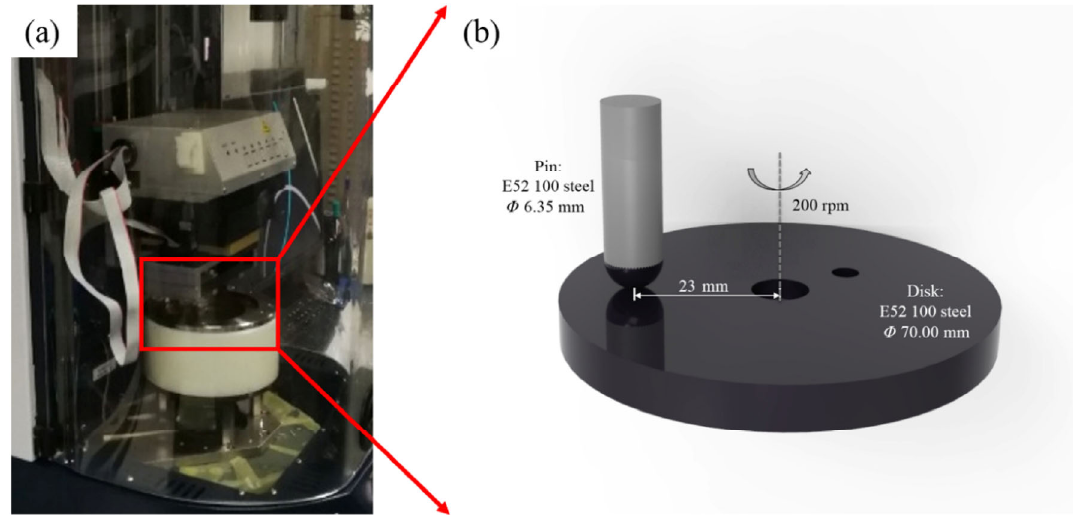
Fig. 1 Tribological setup: (a) photograph of the testing apparatus and (b) schematic of the pin-on-disk tribological equipment